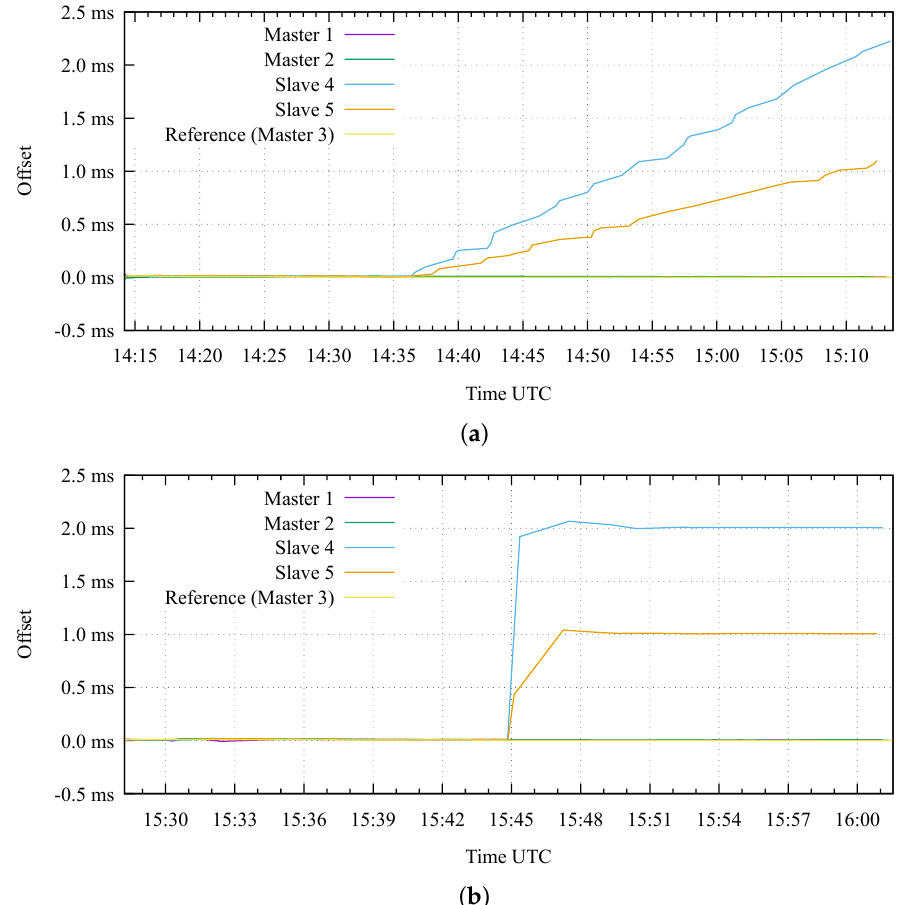
Figure 7. Obtained results on the testbed during the first attack against the software integrity ( a ) and the second attack against the configuration of the Precision Time Protocol (PTP) daemon ( b